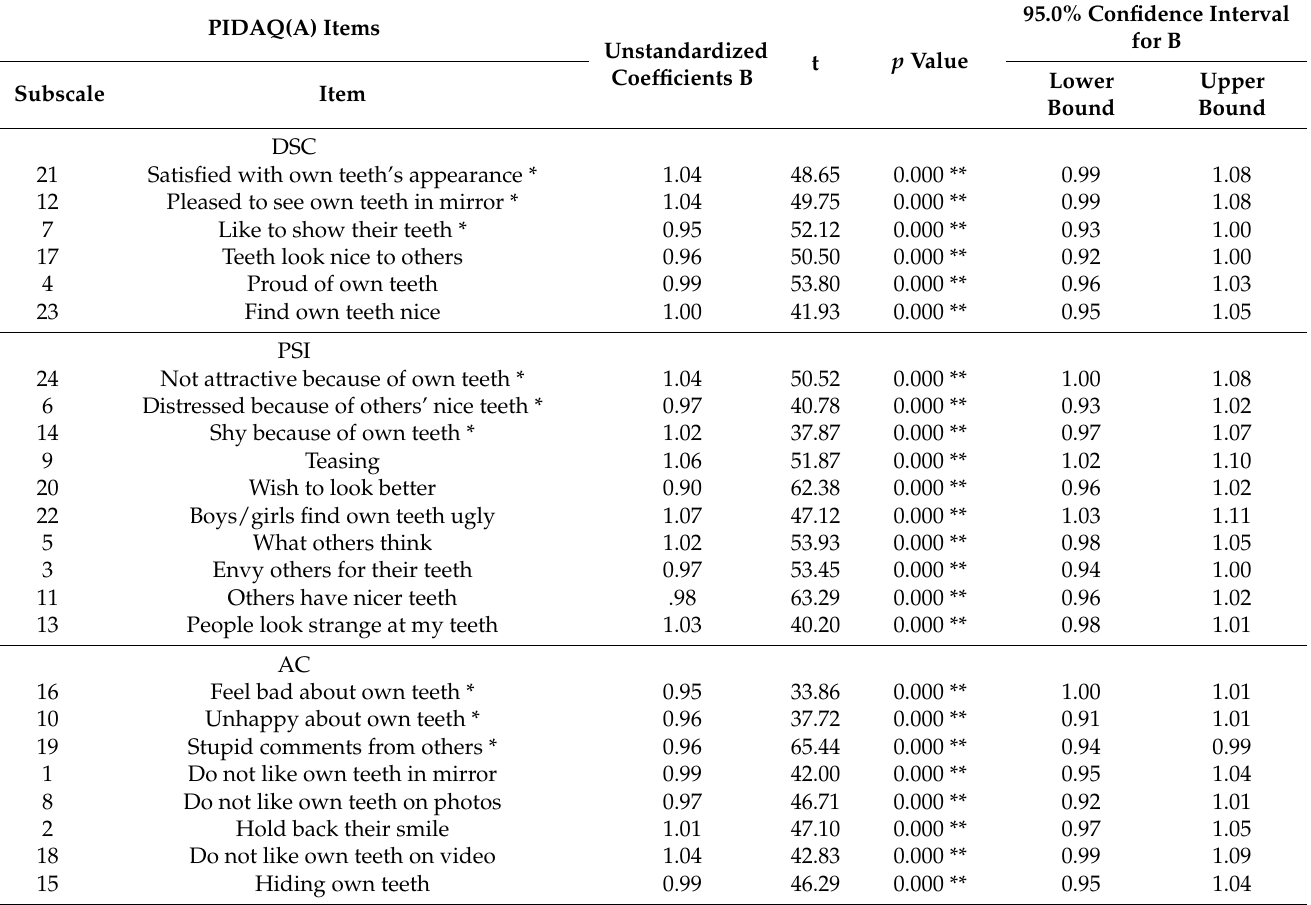
Table 2. Forward regression model: the total aggregate score for the PIDAQ(A) is the dependent variable, and all items are the independent variables (N = 385).